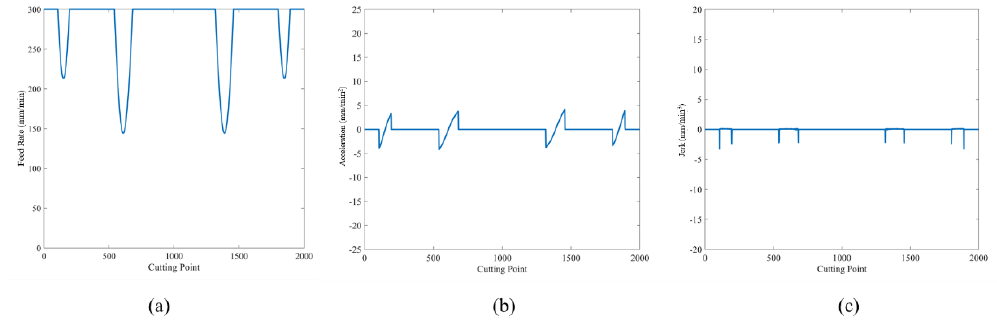
Figure 14. Cutting ∞ shape using method by Luan et al. [9]: ( a ) feed rate, ( b ) acceleration, and ( c ) jerk.